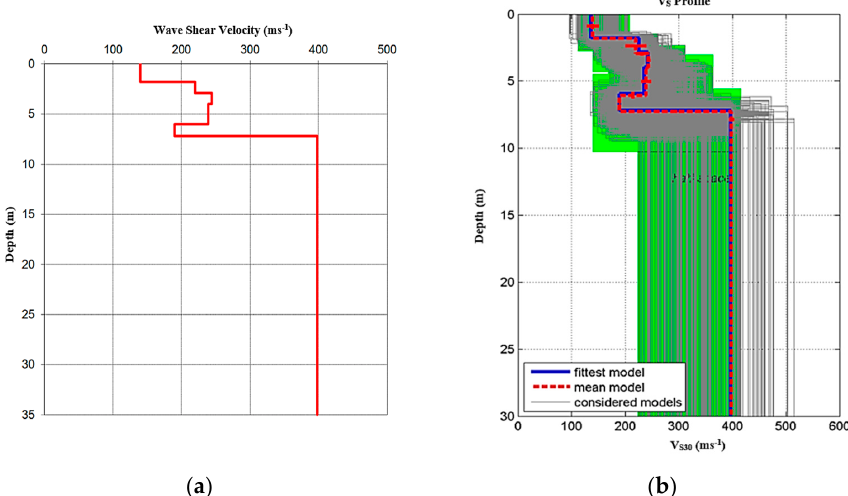
Figure 12. Distribution of shear waves: ( a ) Multichannel Analysis of Surface Waves (MASW) test result; and, ( b ) median value of shear velocity